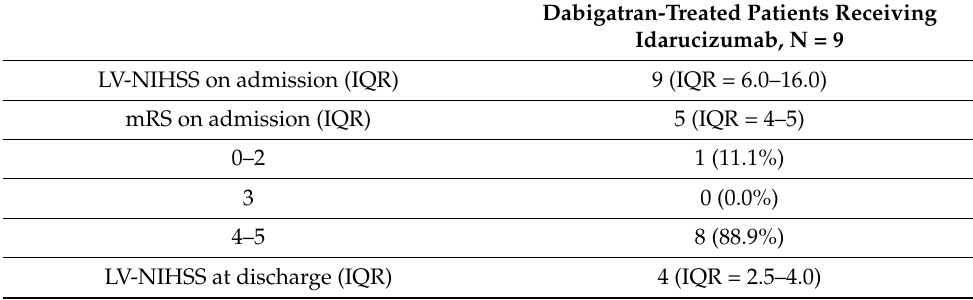
Table 3. Functional outcomes of ischemic stroke